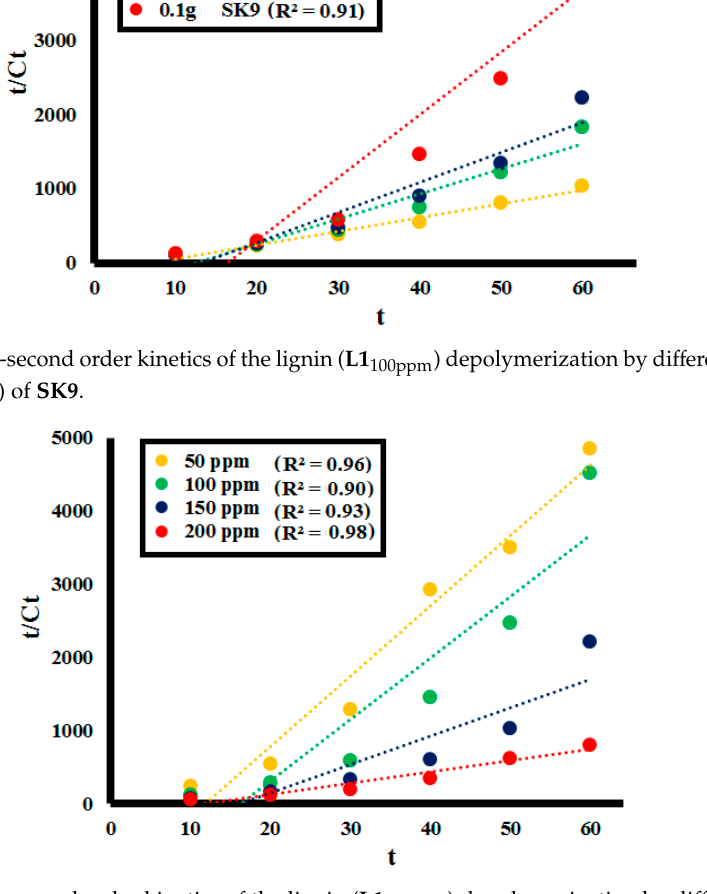
Figure 16. Pseudo-second order kinetics of the lignin ( L1 100ppm ) depolymerization by di ff erent initial lignin concentrations (50–200 ppm).